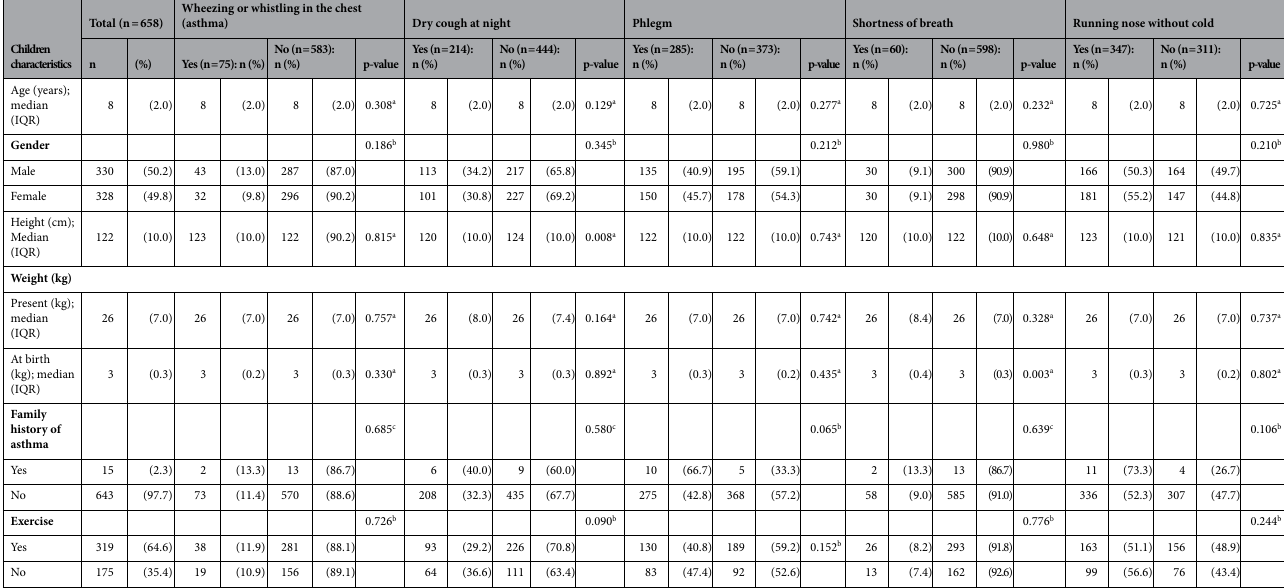
Table 1. Children characteristics and respiratory symptoms (12 months) (n = 658). a Mann–Whitney U test, b Pearson Chi-square test, c Fisher’s exact